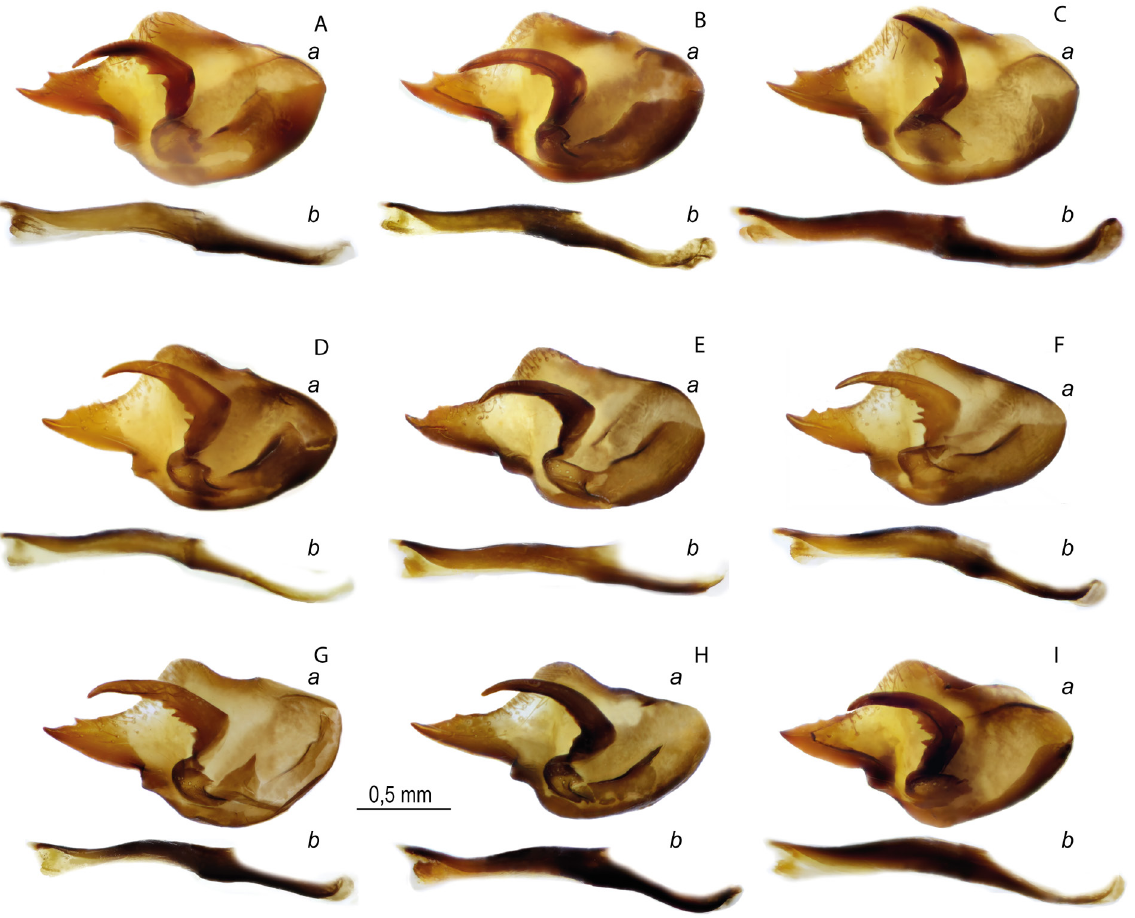
Fig. 22. Male genitalia of Melitaea shahvarica sp. nov. (a = valva; b = aedeagus). Iran, Semnan